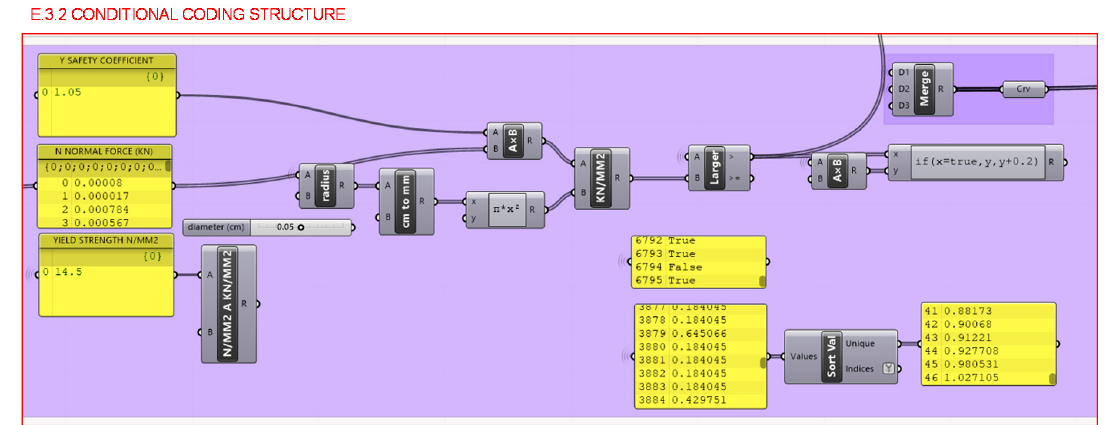
Figure 33. Programming structure definition of the comparison and conditional sequence to check the stiffness of the bars and resizing the bars in the event of being below the elastic limit.